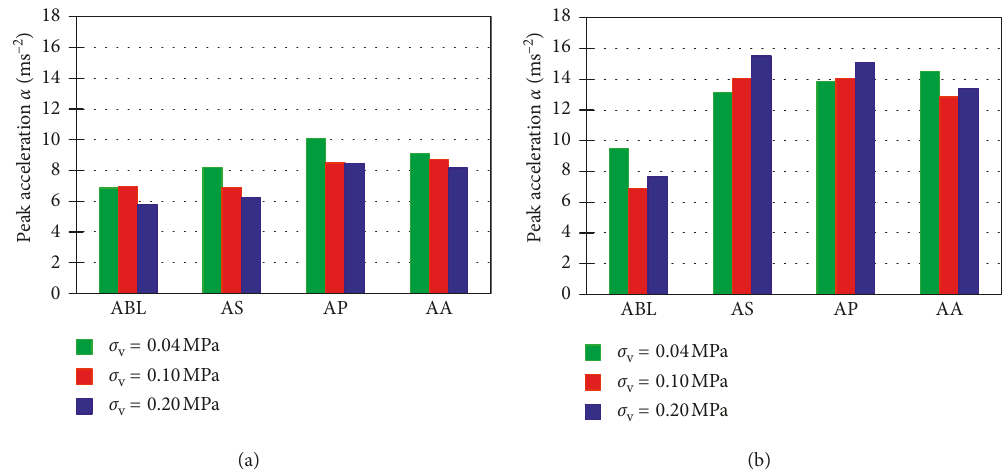
Figure 27: The effect of vertical contact stress below the foundation on peak horizontal acceleration a . (a) PGA � 0.2 g. (b) PGA � 0.6g.